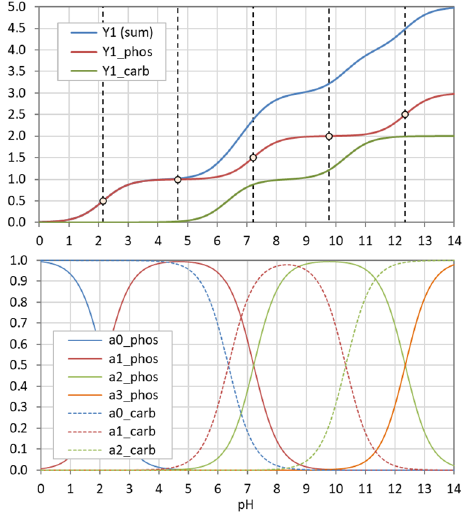
Figure 26. Y 1 and a j for a system composed of phosphoric and carbonic acid.